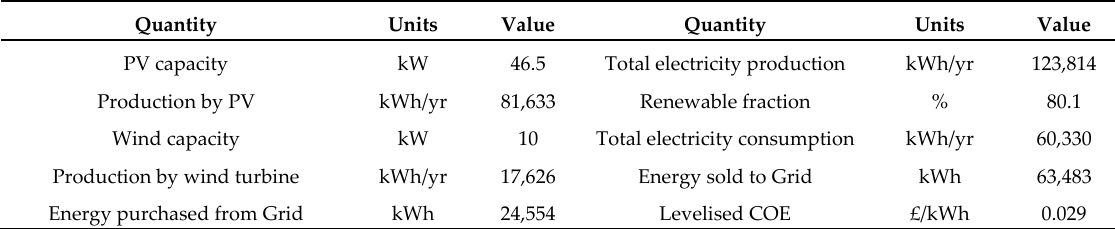
Table 1. Simulation results for the hybrid energy system.